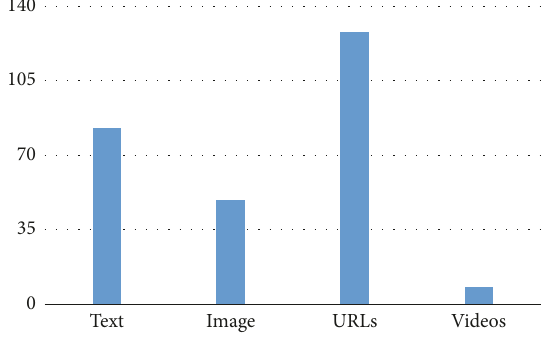
Figure 5: Including additional content to the